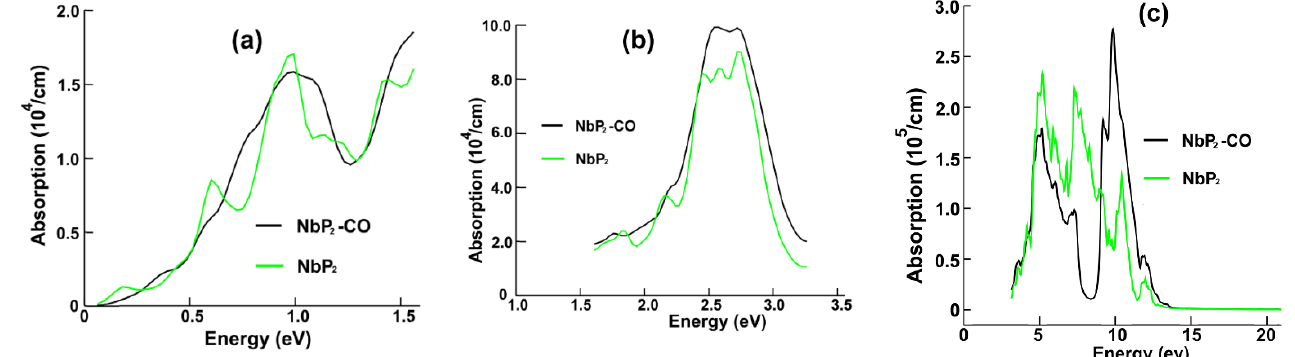
Figure 7. Optical absorption for pristine NbP 2 and NbP 2 -CO; ( a ) in the infrared range; ( b ) for the visible region; ( c ) for the ultraviolet range.